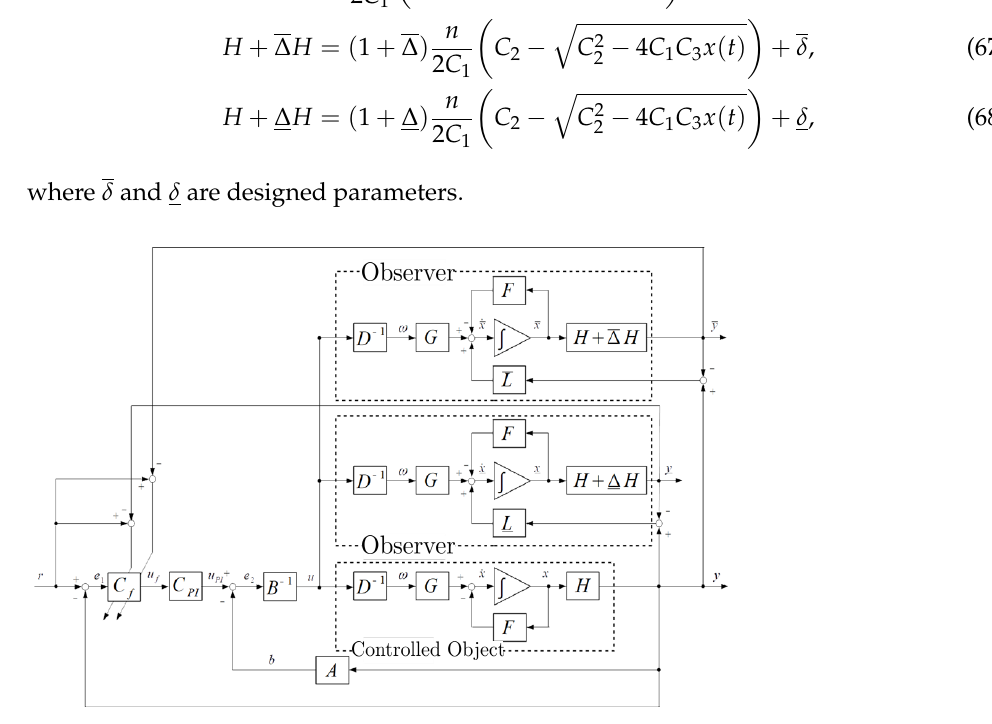
Figure 7. The adaptive control system using the